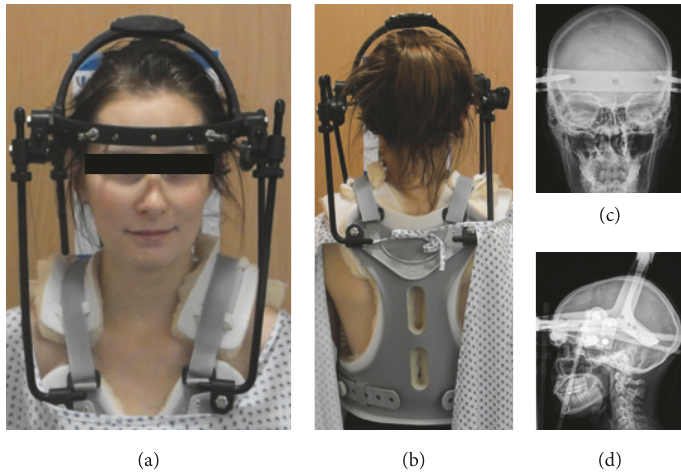
Figure 2: Halo fixation. (a) Front view, (b) rear view, (c) frontal view, and (d) lateral view.